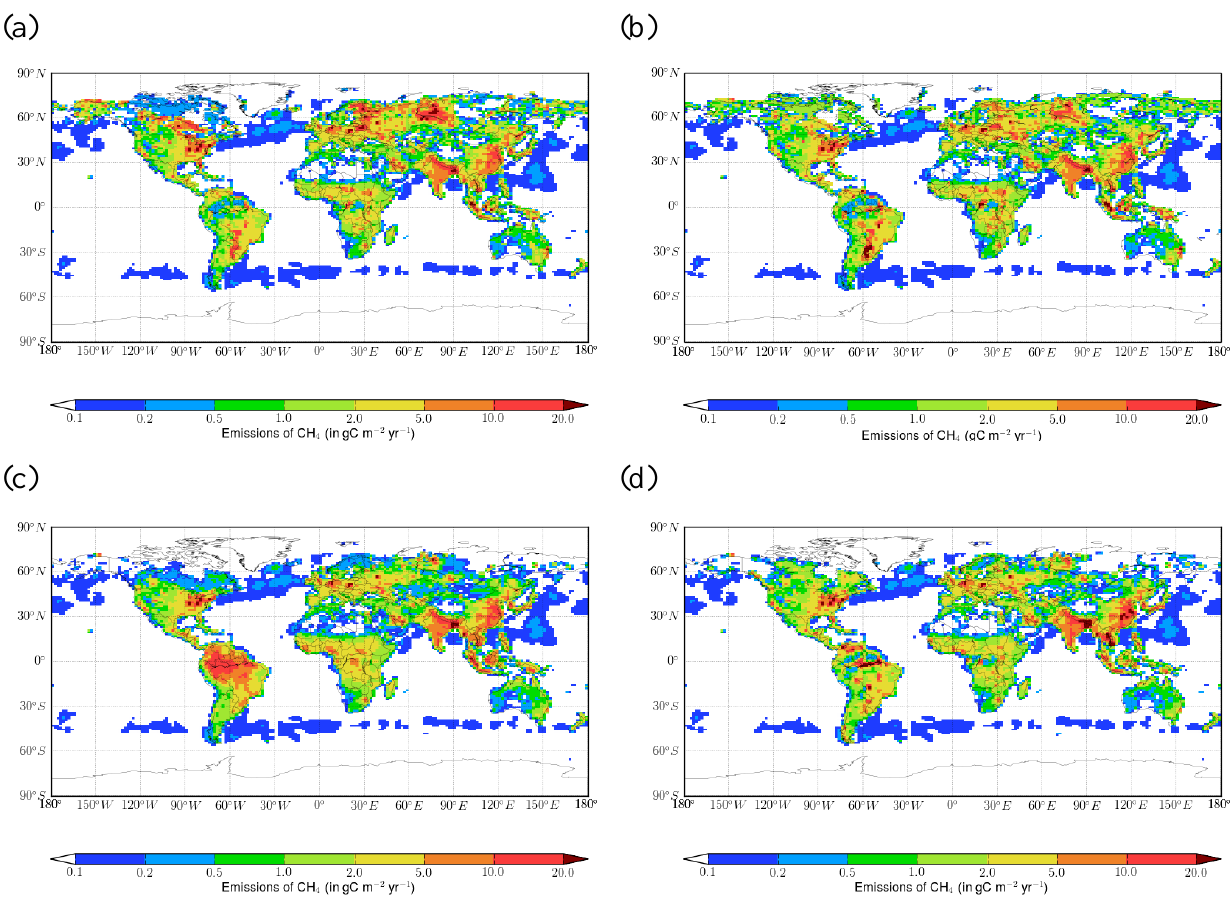
Figure 2. Maps of the global annual emissions of methane from all sources for the year 2000 using wetland emissions based on (a, b) the data set of Fung et al. (1991) (FUNG and TRANSCOM FUNG), (c) an offline JULES run (JULES) and (d) the same JULES run in which the modelled wetland fraction is replaced by that in the GIEMS product, corrected for rice paddy fields